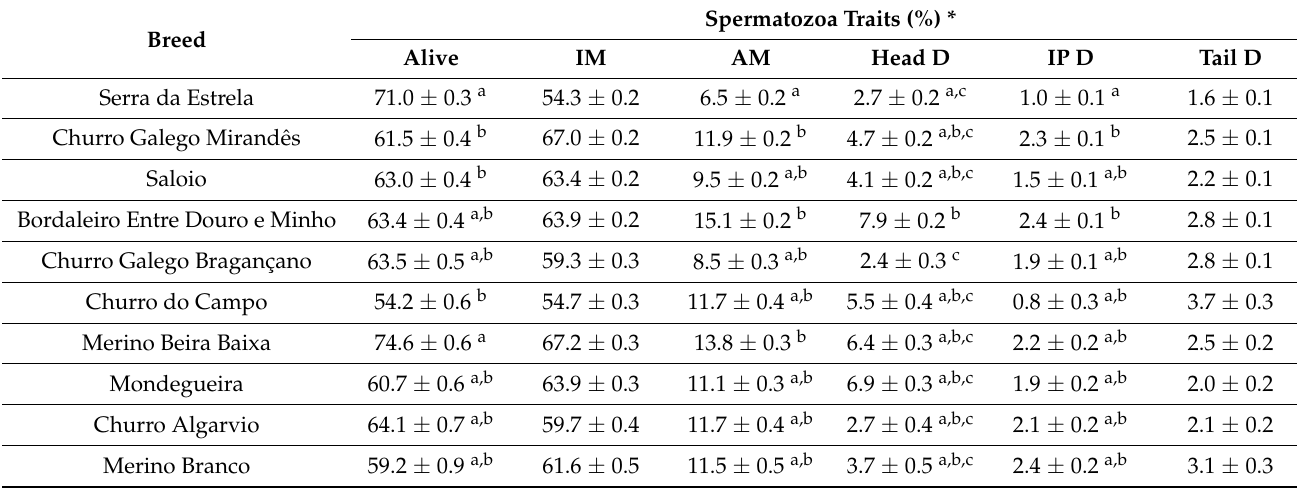
Table 5. Effects of breed and breed × semen processing interactions on spermatozoa traits of fresh semen.